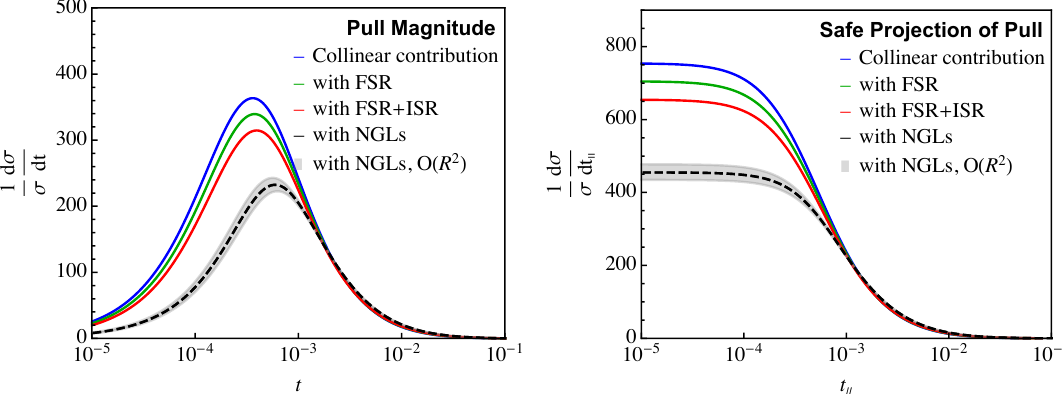
Figure 2 . Impact of the di(cid:11)erent contributions to all-order next-to-leading logarithmic resumma- tion of the pull magnitude (left) and the safe projection t (right). Soft gluon contributions at wide k angle are included as an expansion in the jet radius R through O ( R 2 ), while the non-global loga- rithmic contribution is accounted for at O ( R 0 ). At this accuracy the distribution of the orthogonal projection t ? is identical to t k